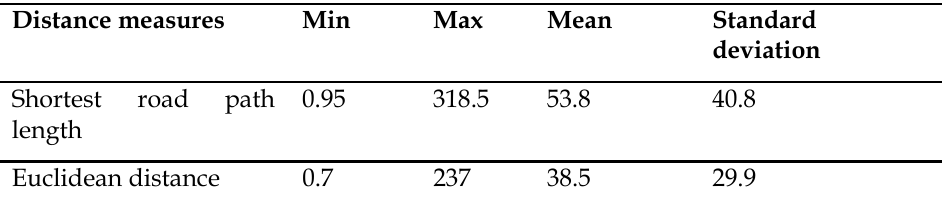
Table 1. Shortest road path versus Euclidean distance: statistical properties (measures in